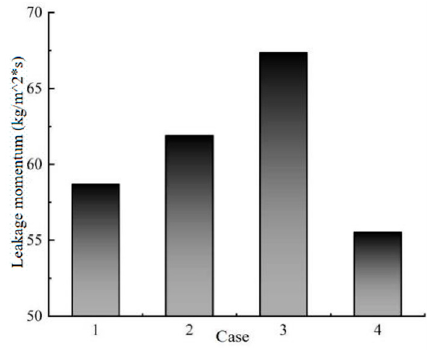
Figure 12. Momentum of the leakage